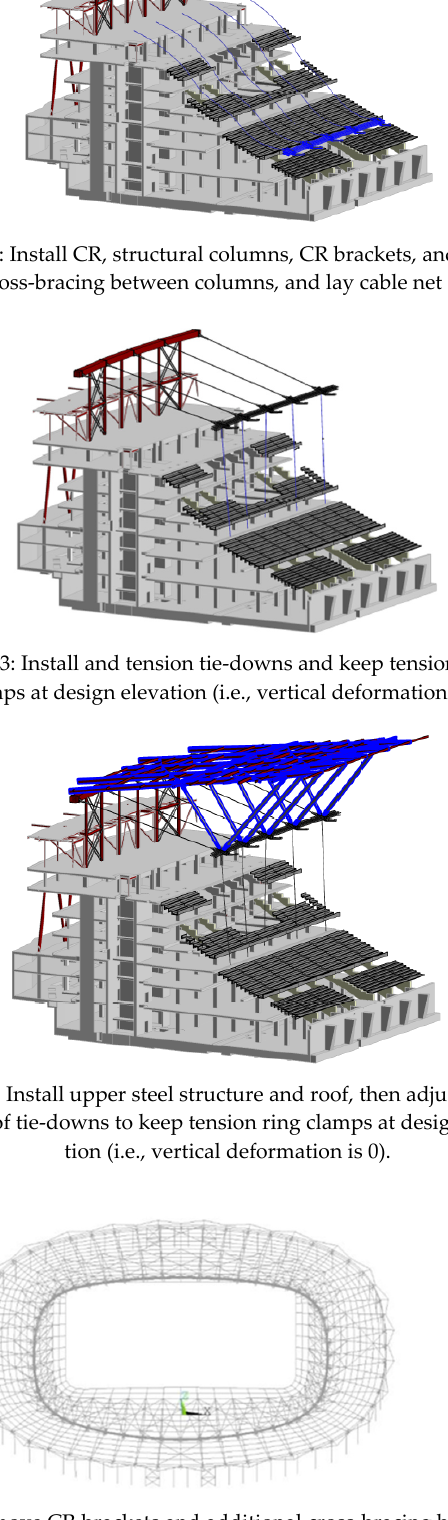
Figure 6. Schematic diagram of detailed construction steps for roof of Education City Stadium in Qatar.